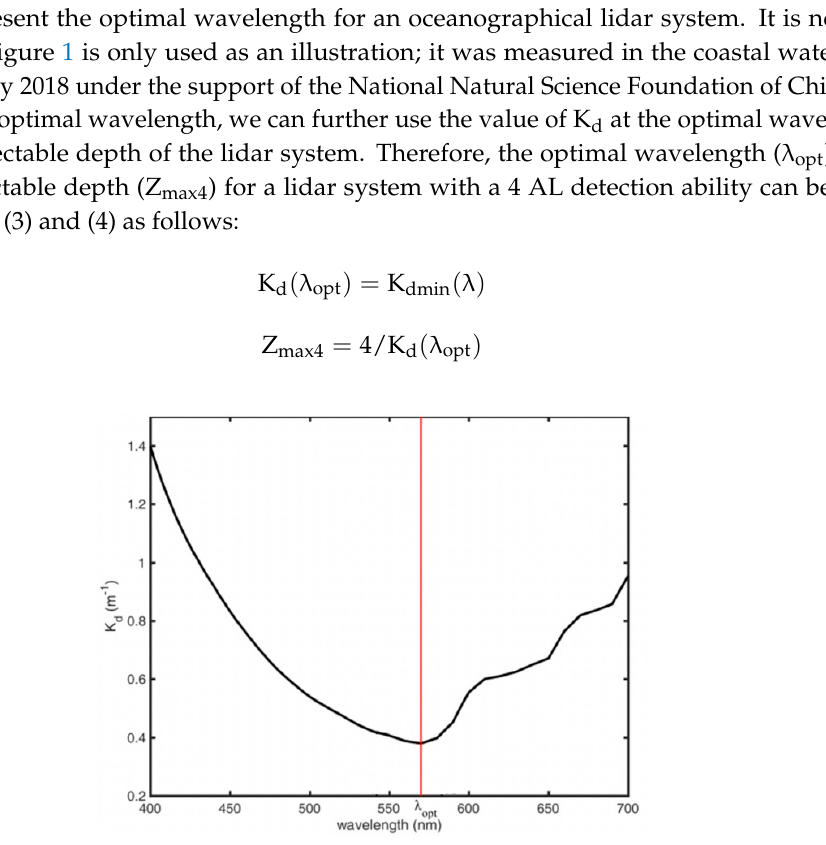
Figure 1. Definition of the optimal wavelength.